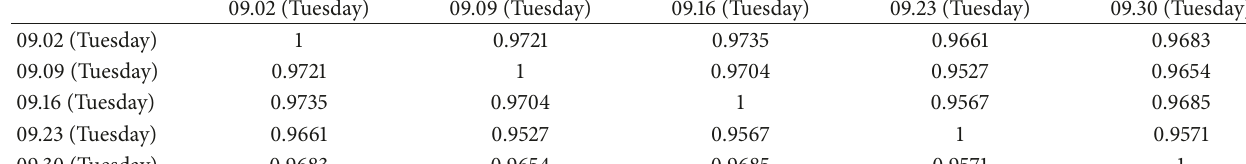
Table 4: Correlation coefficient matrices of two traffic volume series from the same detector located at urban expressway but in different Tuesday.